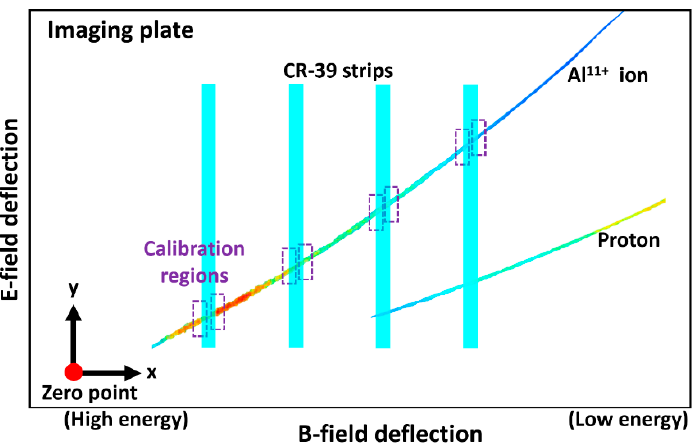
Figure 2. Schematic layout of the CR-39 strips on the IP. The laser-driven Al ions that are deflected inside the TPS leave traces on the CR-39 strips and BAS-TR IP. Calibration regions are marked as purple rectangles in the figure. At each boundary of the calibration region, PSL/ion values are measured by comparing the number of tracks on the CR-39 and the amount of PSL from the IP.